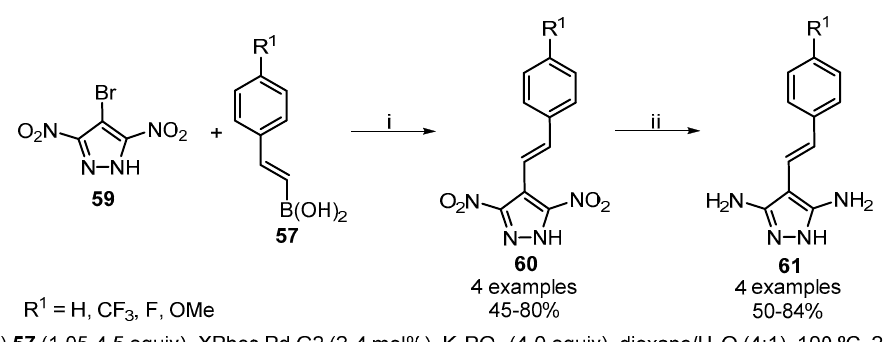
Scheme 17. Synthesis of ( E )-3,5-dinitro-4-styryl-1 H -pyrazoles 60 and iron-catalyzed reduction of the nitro groups to produce ( E )-3,5-diamino-4-styryl-1 H -pyrazoles 61 [77]. Starting from 4-iodo-1-(4-nitrophenyl)-1 H -pyrazole 62 and 4-methoxystyrene 63 , Miller et al.